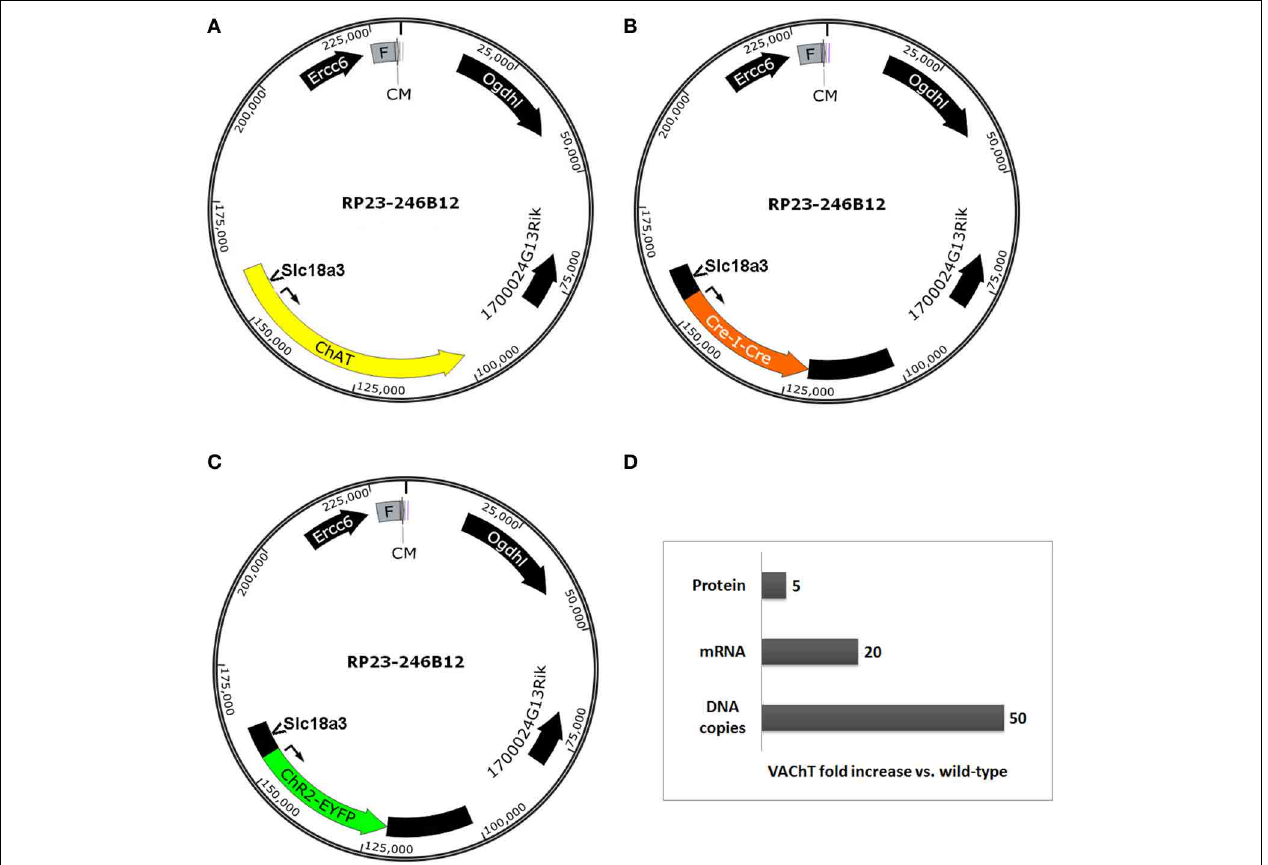
FIGURE 3 | Extra genes contained within BAC clones can result in unintended gene overexpression in BAC transgenic lines. Simplified diagrams of the Chat -spanning BAC clone RP23-246B12 (A) that was modified for expression of (B) Cre recombinase (GENSAT BAC ID BX1191) or (C) ChR2(H134R)-EYFP under the control of the Chat gene promoter elements. Several extra genes are contained in the BAC clone, including Ercc6 (partial), Ogdhl, 1700024G13Rik , and Slc18a3 . Notably,